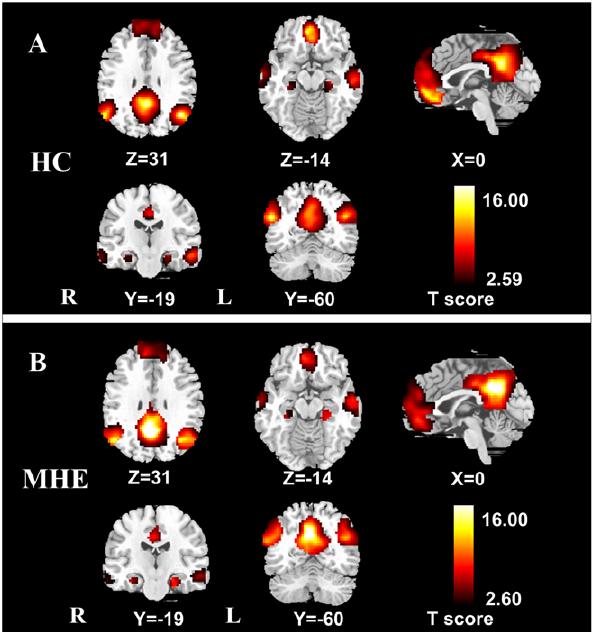
Figure 1. Within-group DMN maps of healthy controls and MHE patients. A: DMN in the healthy controls ( t . 2.59, P , 0.01, FDR corrected). B: DMN in the MHE patients ( t . 2.60, P , 0.01, FDR corrected). The DMN in healthy controls and MHE patients shows functional connectivity among the PCC/PCUN, the MPFC, the bilateral IPL, PHG, and ITG. DMN=default mode network; MHE=minimal hepatic enceph- alopathy; FDR=false discovery rate. PCC/PCUN=posterior cingulate cortex/precuneus; MPFC=medial prefrontal cortex; IPL=inferior parie- tal lobule; PHG=parahippocampal gyrus; ITC=inferior temporal cortex.